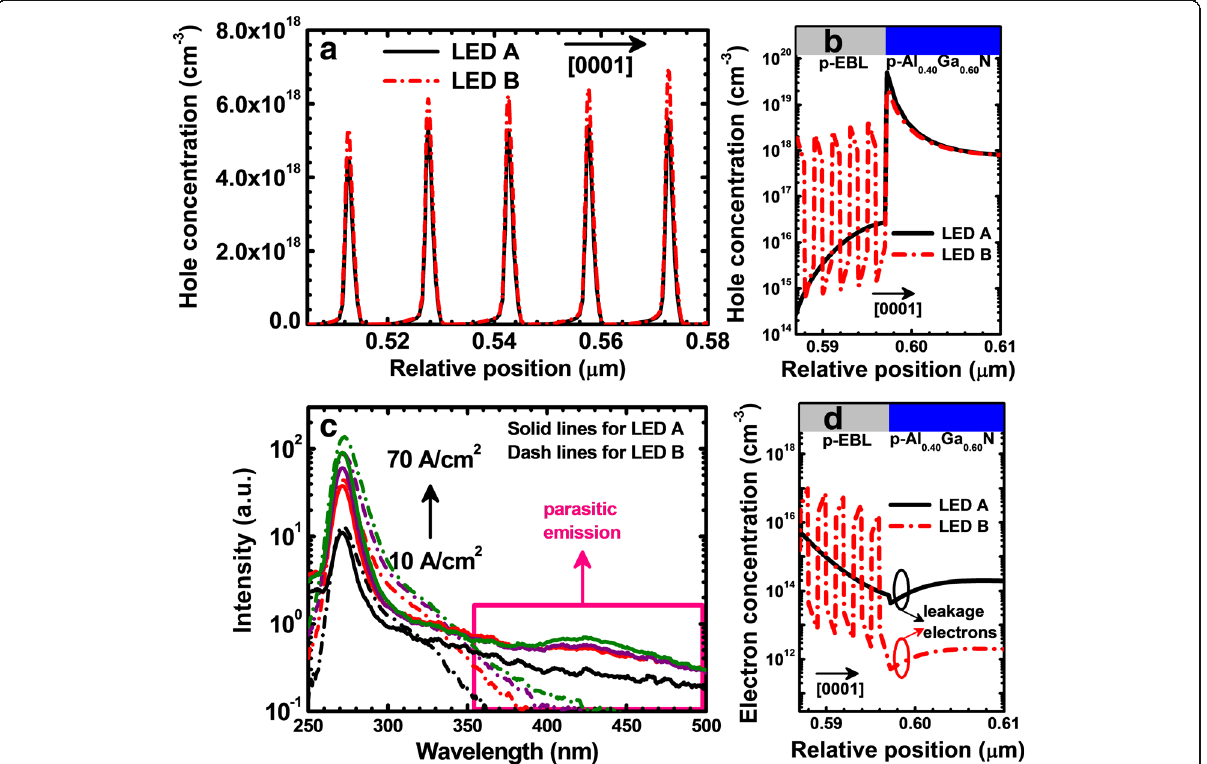
Fig. 3 Numerically calculated hole concentration profiles a in the MQWs and b in the p-type hole injection layers for LEDs A and B, respectively; c experimentally measured EL spectra in semi-log scale at the current density of 10, 30, 50, and 70 A/cm 2 for LEDs A and B, respectively; d numerically calculated electron concentration levels in the p-type hole injection layers for LEDs A and B. Numerically calculated data are collected at the current density of 50 A/cm